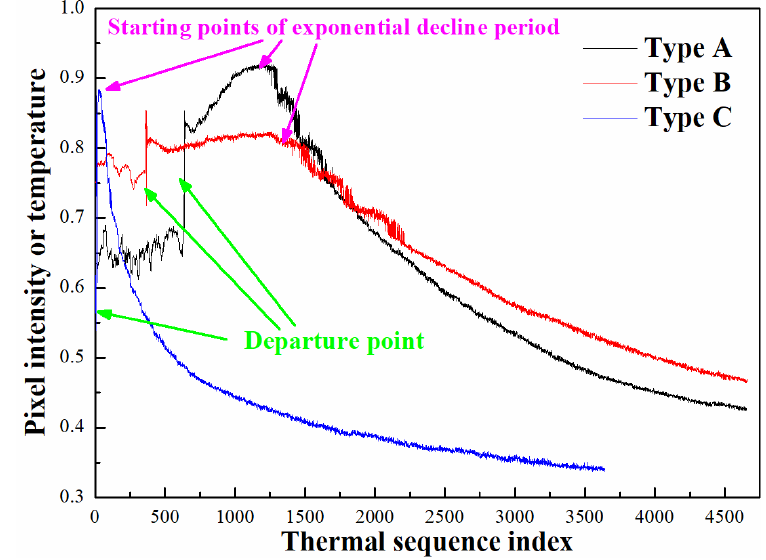
Figure 3. Three typical thermal curves extracted from raw thermal